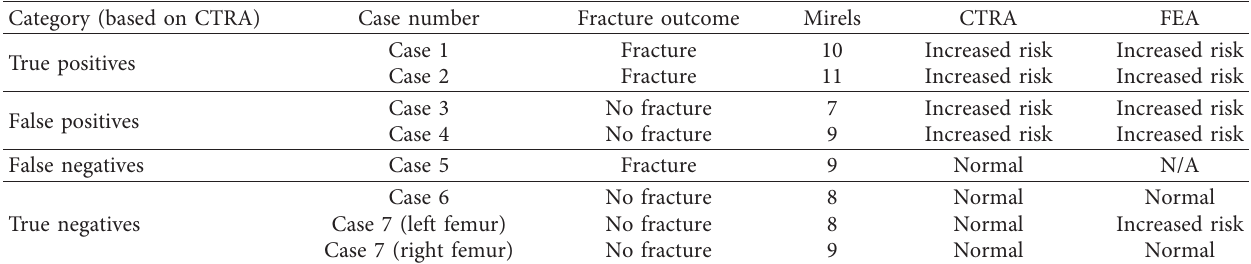
Table 1: Case summary based upon CTRA statistical outcome.